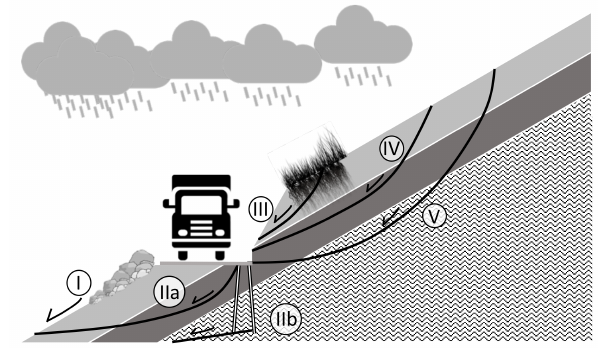
Figure 1. There are five primary modes of potentially damaging mass movements caused by informal road construction in Nepal – (I) debris flows from excavated material stored on the downs- lope side of the road; (II) deeper seated landslides that are accom- modated by poor road drainage as water seepage can aid failures that include regolith (IIa), and freeze–thaw in joints that can re- sult in bedrock failures (IIb); (III) shallow failures close to the road caused by oversteepened road cuts that may be mitigated by plant- ing; (IV) shallow landslides caused by oversteepening that include potentially stabilizing roots from vegetation; (V) deeper seated fail- ures triggered by oversteepening by road cuts that may include bedrock.